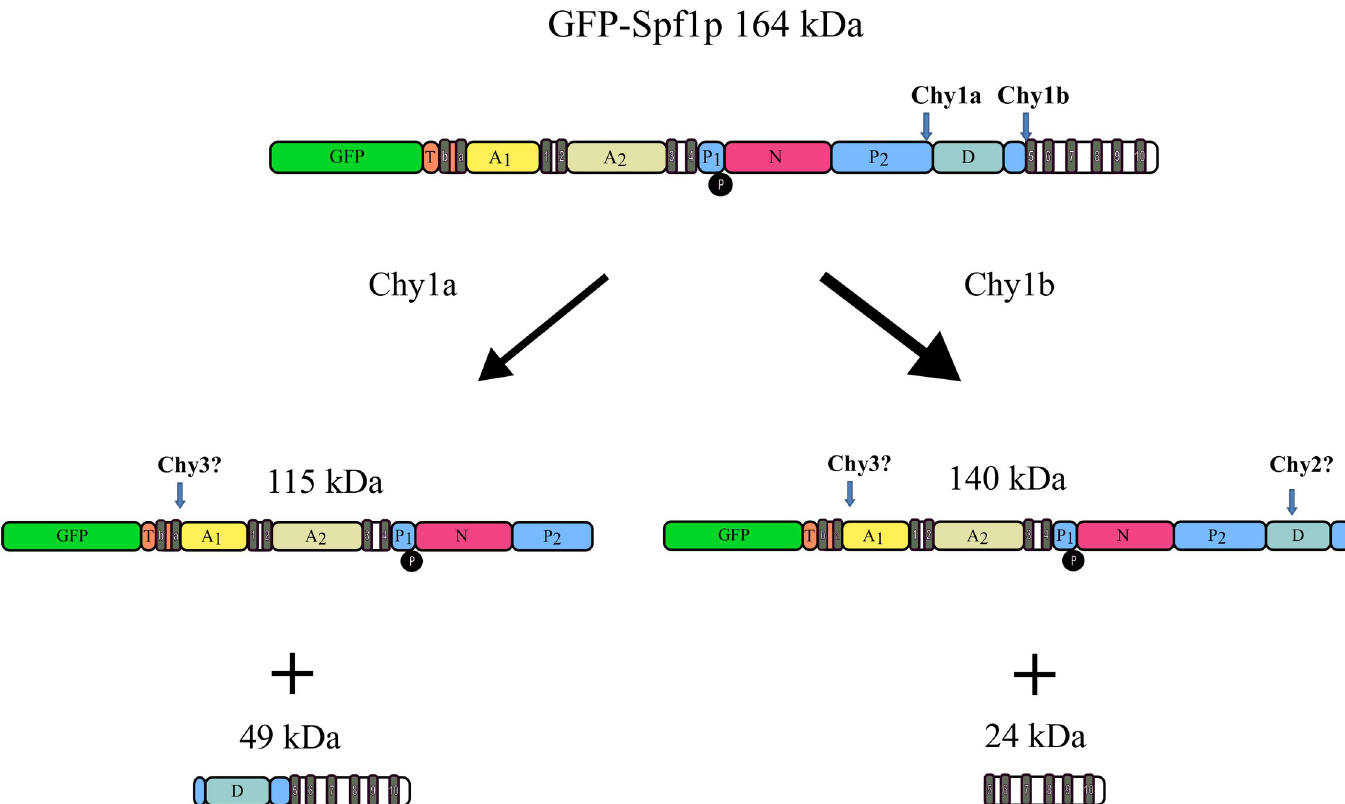
Scheme 1. Schematic representation of the initial chymotryptic cleavage of the N-terminally-GFP fused Spf1p. Each cylinder represents a domain or subdomain of the protein. The length of the cylinder was made approximately proportional to its number of amino acid residues. A , P , N , P-ATPase actuator, phosphorylation and nucleotide domains. T , and D , P5A-ATPase unique P5A-ATPase regions. Transmembrane segments are represented as grey vertical cylinders, and the location of the catalytic phosphorylation is shown as a black sphere. The arrows indicate the initial chymotryptic cleavage sites Chy1a and Chy1b , and the possible locations of further proteolysis ( Chy2 and Chy3 ). The Mr indicated are those estimated from the amino acid sequence. The thicker arrow on the right is in accordance with the results showing that the most intense band produced by chymotryptic digestion producing the Chy1 fragment migrated as a peptide of about 140